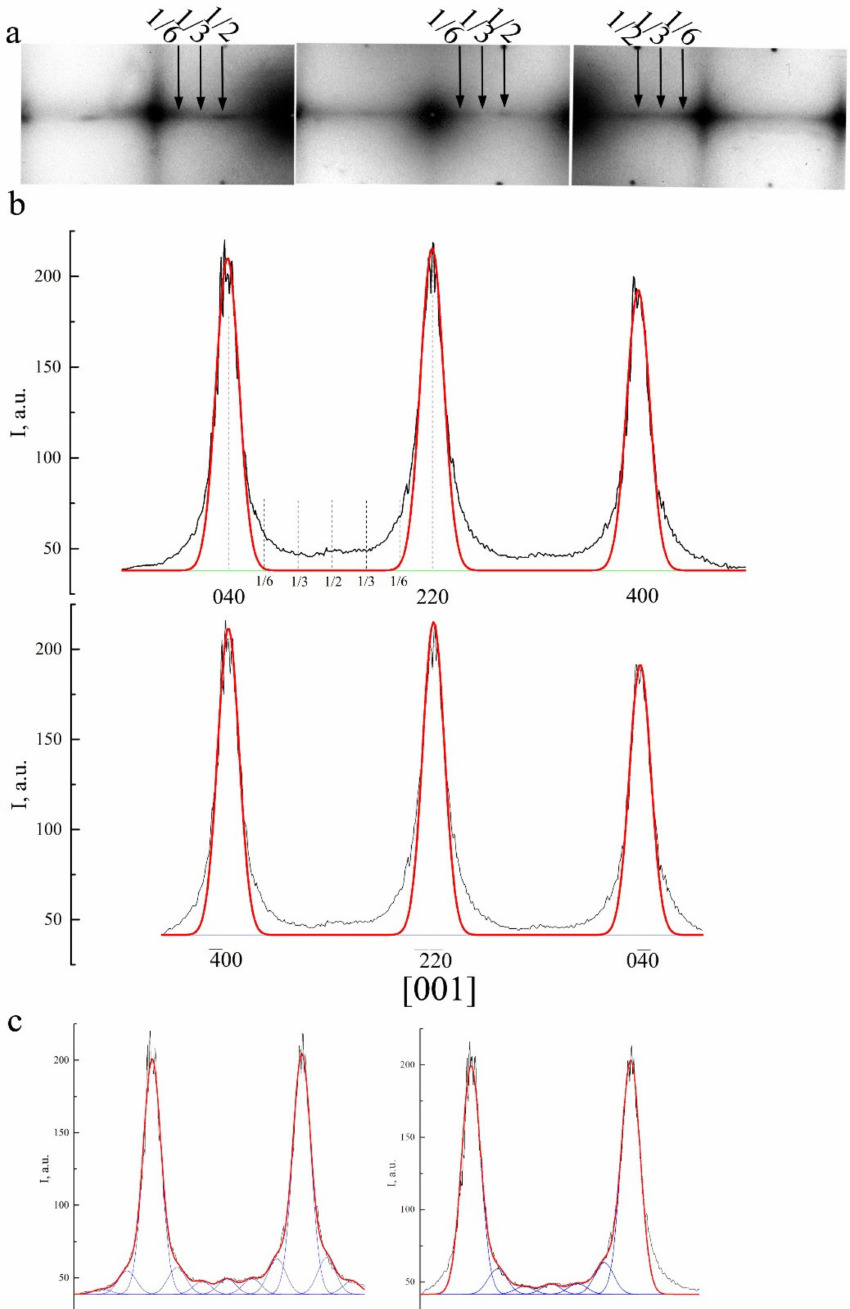
Figure 4. ( a ) Fragments of SAED pattern with zone axis [001]. ( b ) Intensity profile when scanning the diffuse scattering between the fundamental reflections of types 040–220–400 or − 400– − 2-20–0 − 40. ( c ) Intensity profile along the diffuse streaks with calculated profiles for satellites of type 1/6 <220>, 1/3 <220>, 1/2